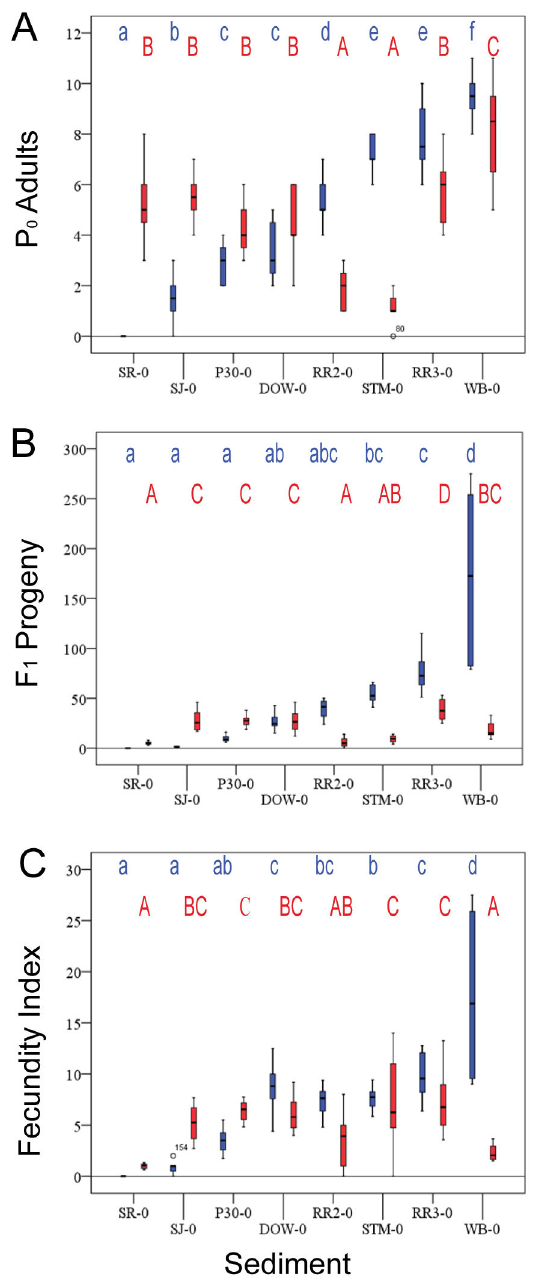
Figure 3. Recovery of P0 adult nematodes and F1 progeny from eight un-spiked test sediments. C. elegans – blue. P. pacificus – red. Box and whisker plots: box represents the range between the 25 th and 75 th percentile (interquartile range). The line within the box represents the median. The whiskers indicate minimum and maximum values, except where circles and stars represent outliers (>1.5 times interquartile range from median) or extreme outliers (>3 times interquartile range from median), respectively. Letters above the box and whisker plots represent significant groupings based upon Tukey post-hoc comparison tests (p< 0.05). Lower case blue letters, C. elegans groupings; capital red letters, P. pacificus groupings. (A) Recovery of added P0 animals. (B) Recovery of L1/J2 progeny. (C) Fecundity Index, total progeny recovered / total live P0 adult nematodes recovered.